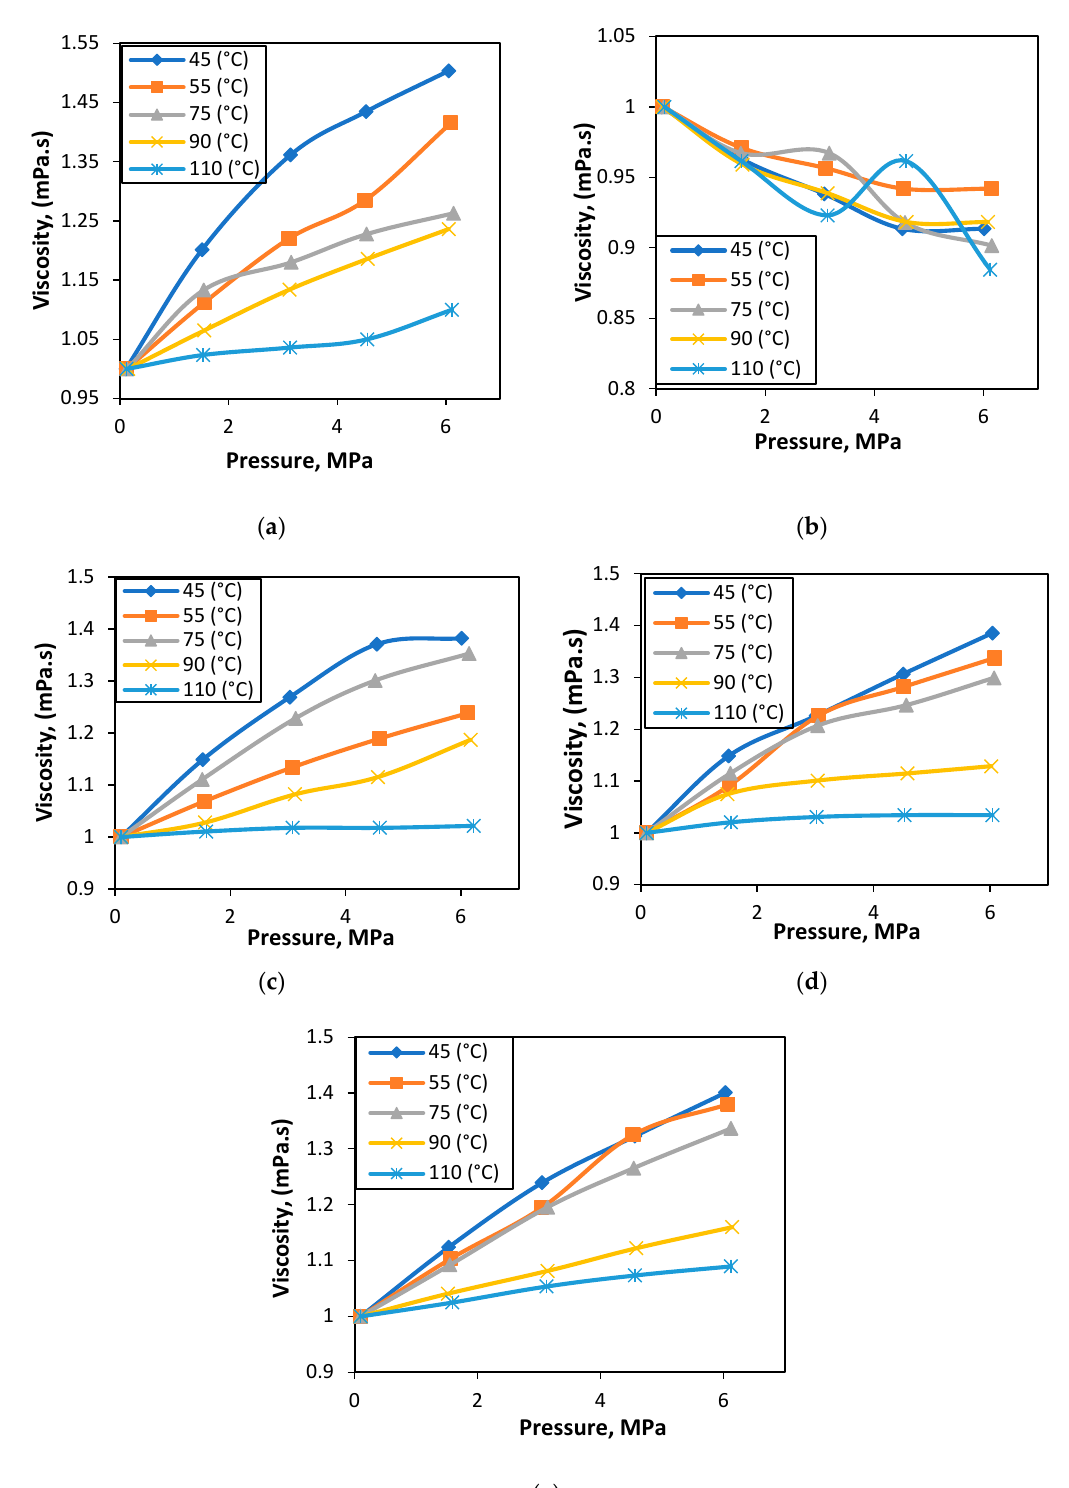
Figure 6. Effect of temperature on the viscosity of the crude oils and their mixtures. ( a ) BT; ( b ) LO; ( c ) M1; ( d ) M2; ( e ) (M3).